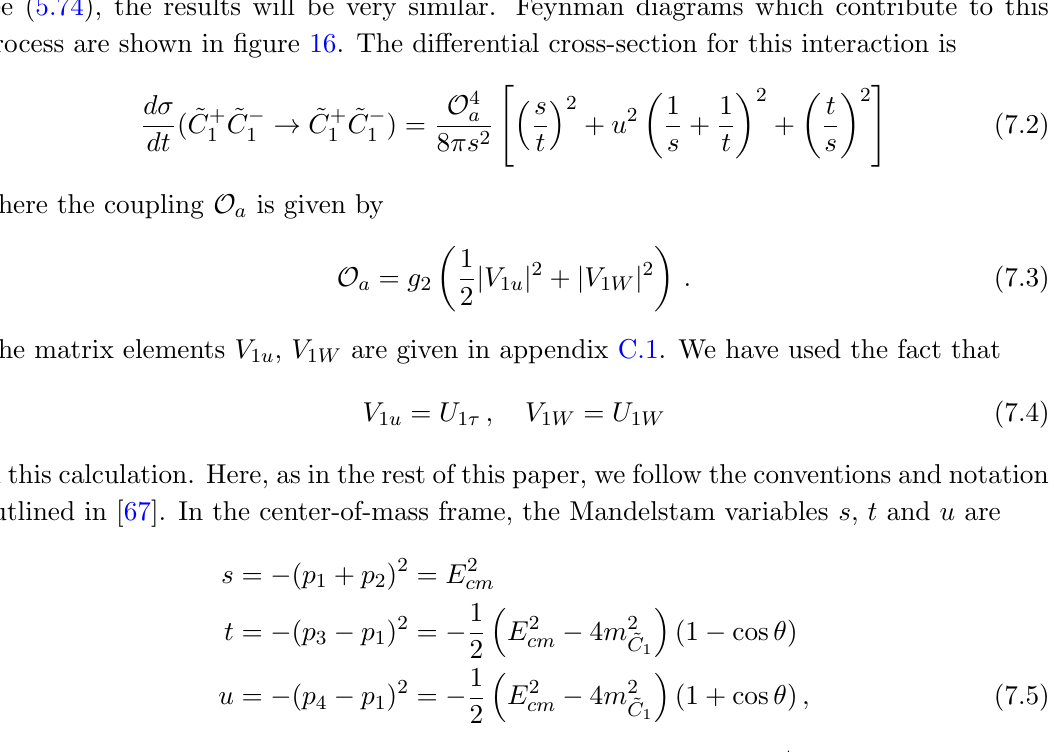
~ C (cid:0) ~ C (cid:0) ! ~ C + scattering process exchanging a W 0 1 1 1 1